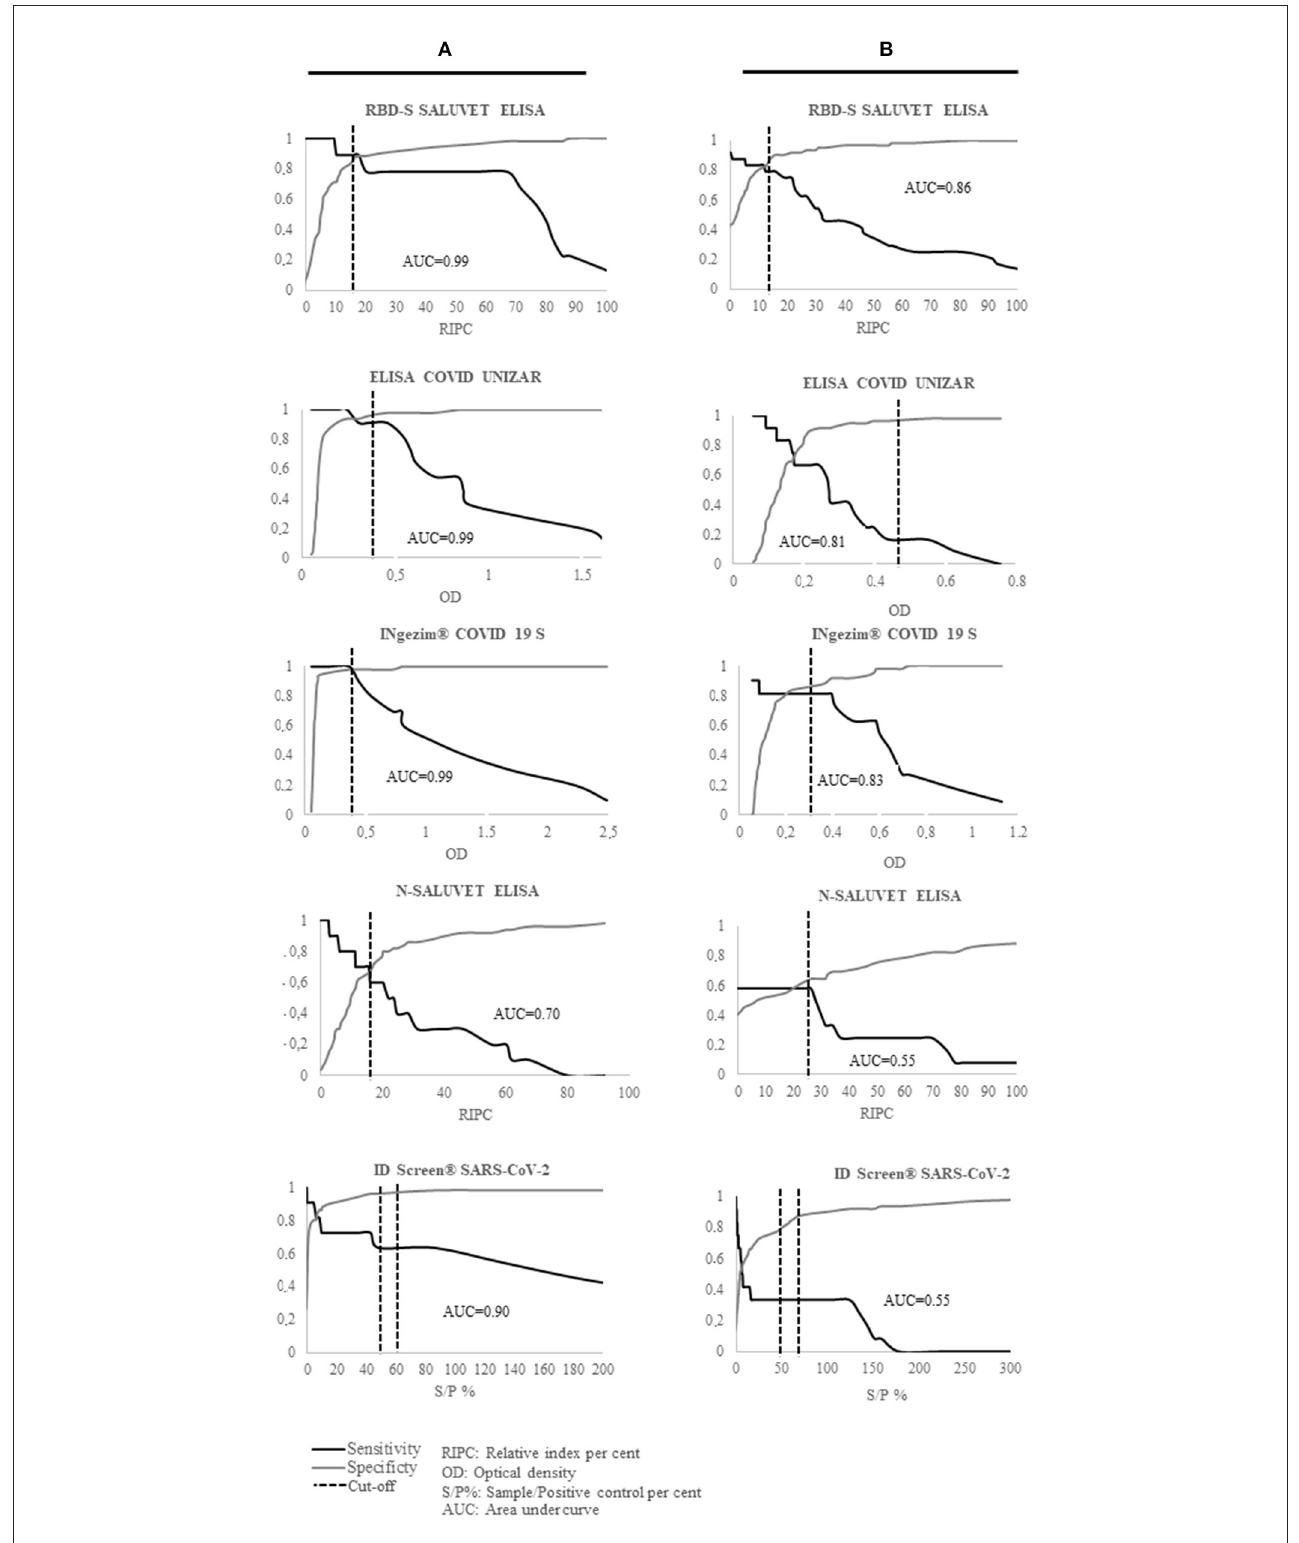
FIGURE1 Two-graph receiver operating characteristics (TG-ROC) analyses based on the reference criterion (VNA and PCR results) and the area under the curve (AUC) values shown by all serological tests developed for cats (A) and dogs (B) . S/P%, sample/positive control percent; AUC, area under curve.